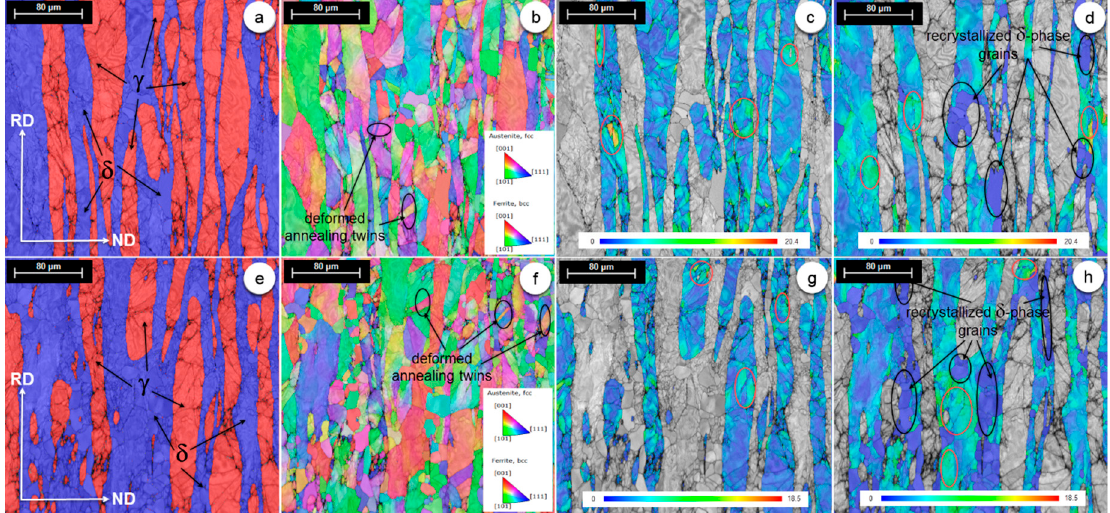
Figure 4. Distribution maps of both the γ - and δ -phases ( a ), inverse pole figure (IPF) ( b ), GROD map of the γ -phase ( c ) and δ -phase ( d ) for the hot ‐ rolled ( HR ) state.